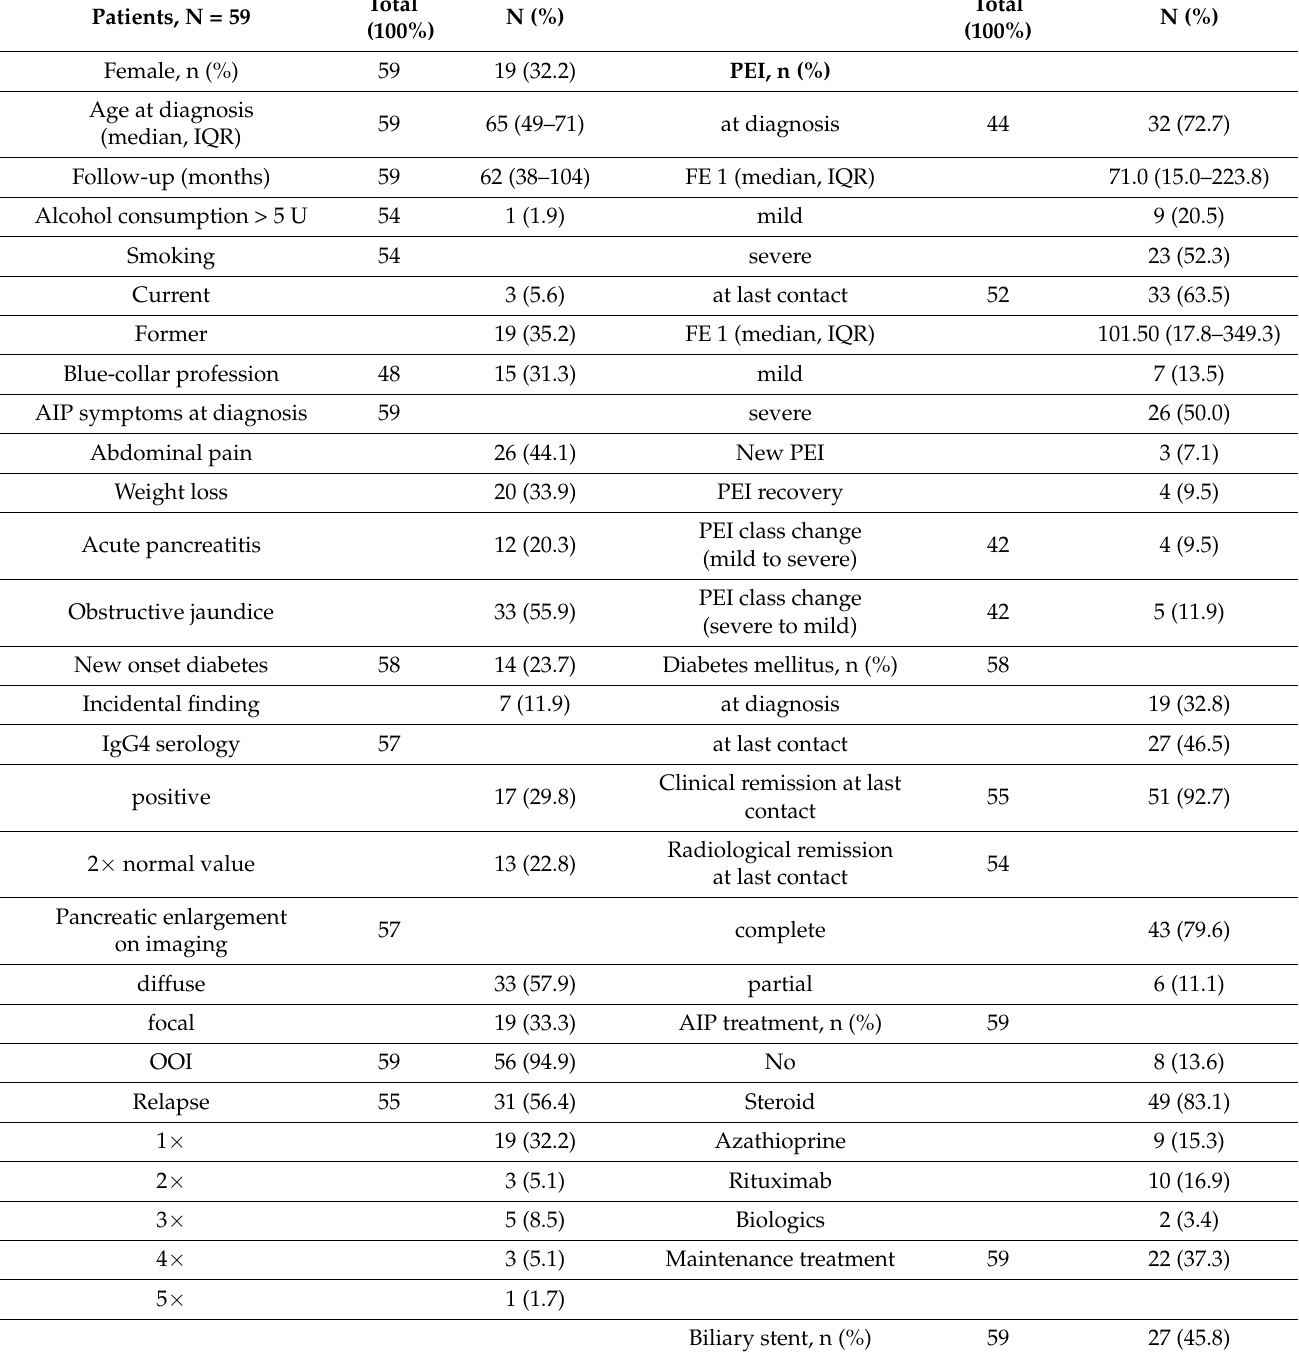
Table 1. Characteristics of patients with AIP type